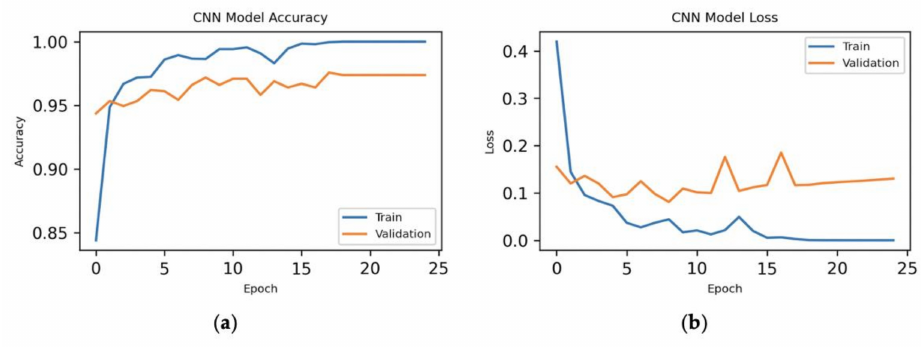
Figure 9. Experimental results for 138 features: ( a ) epoch vs. accuracy and ( b ) epoch vs. loss.